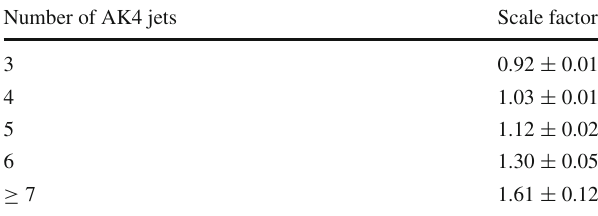
Table 4 The scale factors determined from data for correcting the AK4 jet multiplicity distribution in the simulation. The quoted uncertainties in the scale factors are statistical only